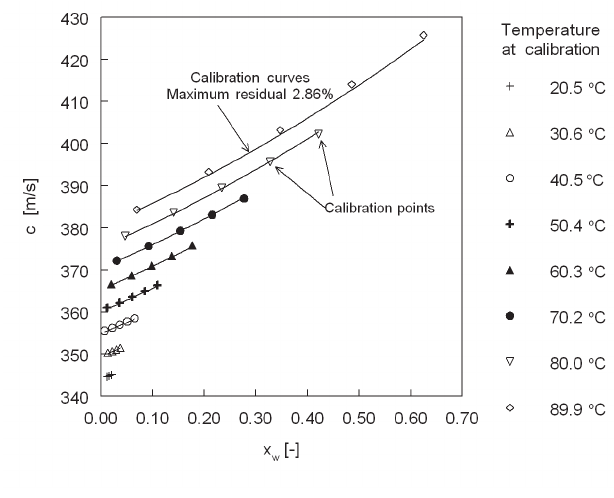
Figure 5. Speed of sound vs. water vapor mole fraction, calibration at various temperatures with the lines representing Equation 2 with constants given in Table